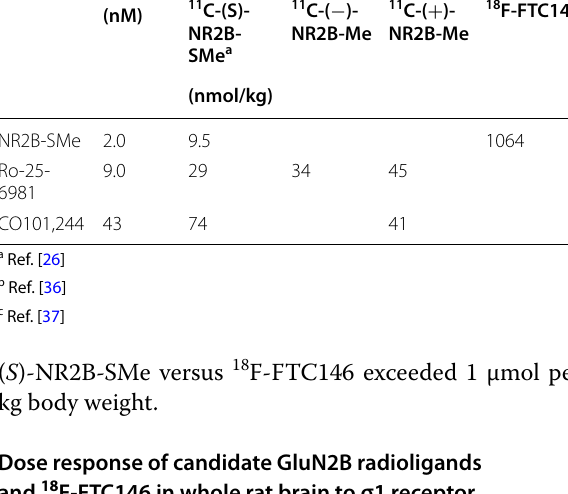
Table 2 In vitro and in vivo pharmacological parameters of unity, indicating near full receptor occupancy at this dose GluN2B (Additional file 1: Figure S10). Non-displaceable bind- ing given by the intercept on the X-axis of Lassen plots was, on average, about 0.42 SUV for each enantiomer. Estimates of BP ND as (SUV BL /SUV ND 1) were 5.0 for − the whole rat brain. BP ND for 11 C-( )-NR2B-Me in dif- − ferent rat brain regions was between 3.4 and 7.6 and for 11 C-( )-NR2B-Me was between 4.6 and 6.9 (Additional + file 1: Figure S10).